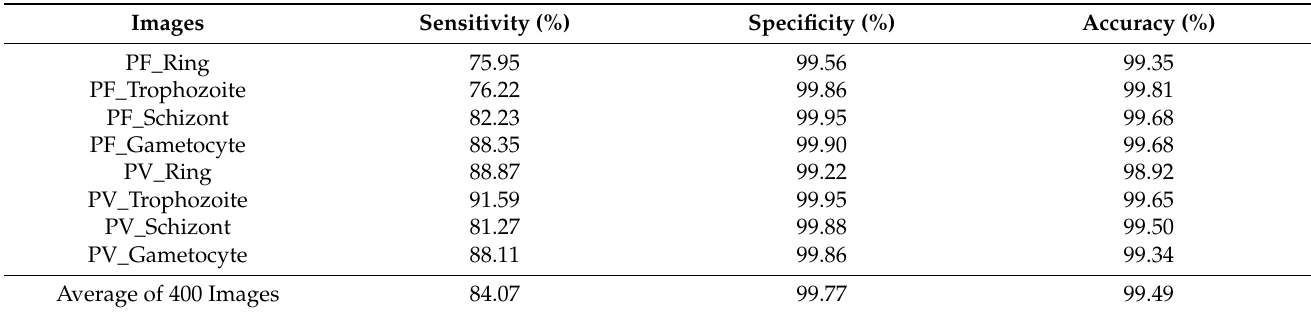
Table 6. Segmentation performances for the final segmented malaria